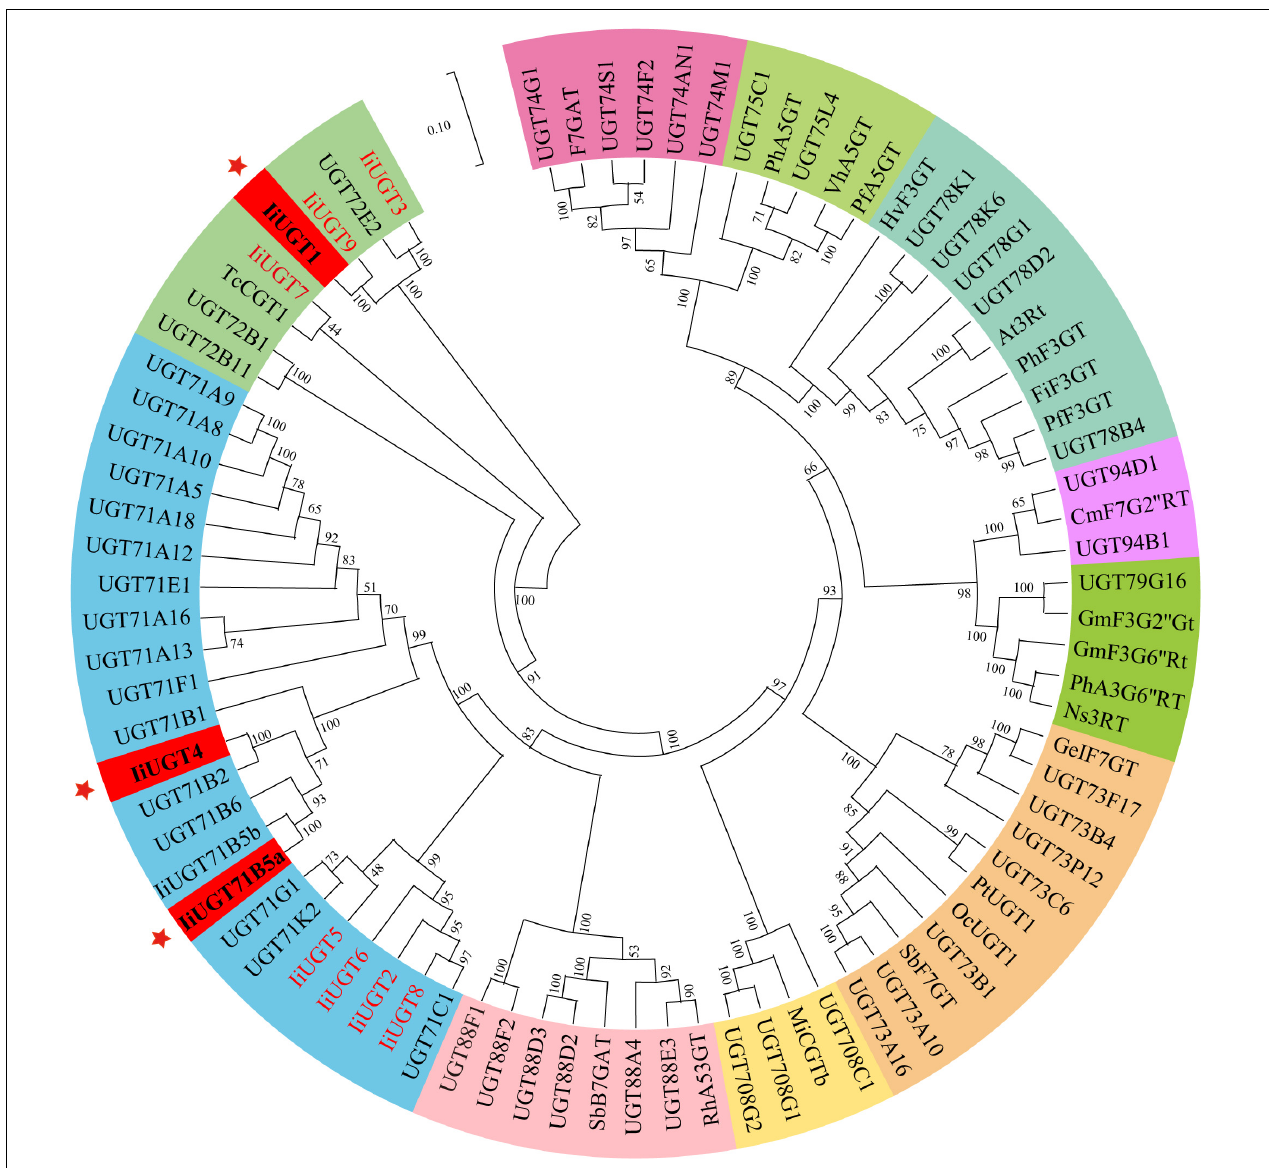
FIGURE 2 | Phylogenetic relationships between candidate IiUGTs and their close relatives. IiUGT genes from this study were in red or blod in black. A Neighbor-Joining phylogenetic tree was constructed the tree with 1000 bootstrap replicates by MEGA7. The GenBank accession numbers of UGT proteins in the tree are in Supplementary Table 2 . The key genes whose functions were characterized in this study were marked with